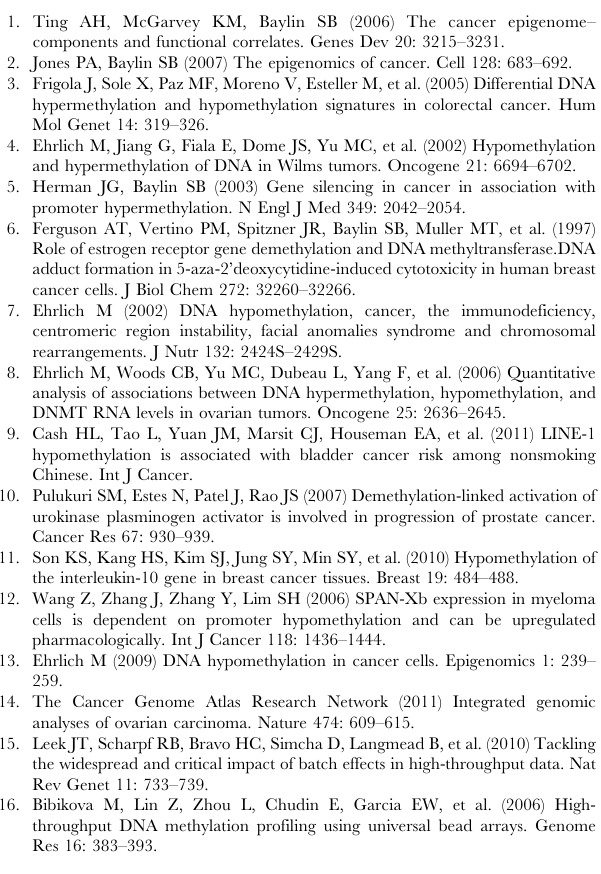
Figure 5. Hypomethylation-specific functions and the hypermethylation-specific functions related to ‘‘response to stimulus’’. (A) Hypomethylation-specific terms related to ‘‘response to stimulus’’. (B) Hypermethylation-specific functions related to ‘‘response to stimulus’’.